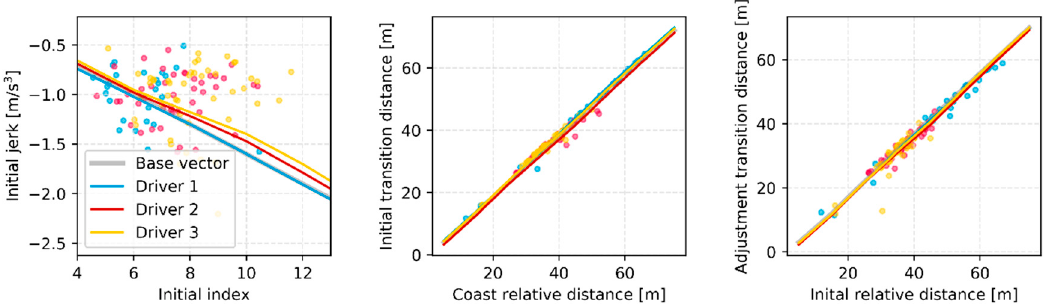
Figure 8. Model parameters and its updated vector for each driver.